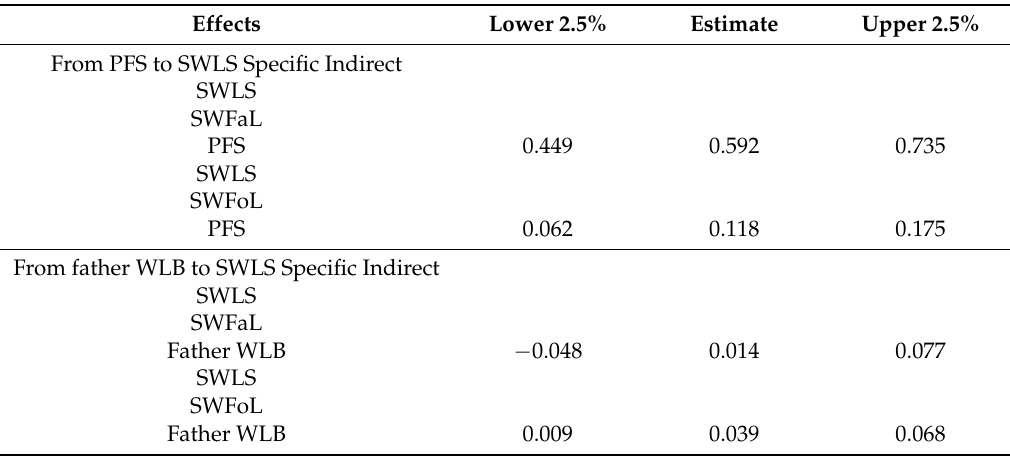
Table 4. Bias-Corrected confidence intervals of specific mediation effects in the model that includes the fathers’ work-life balance (Father WLB). Effects Lower 2.5% Estimate Upper 2.5%